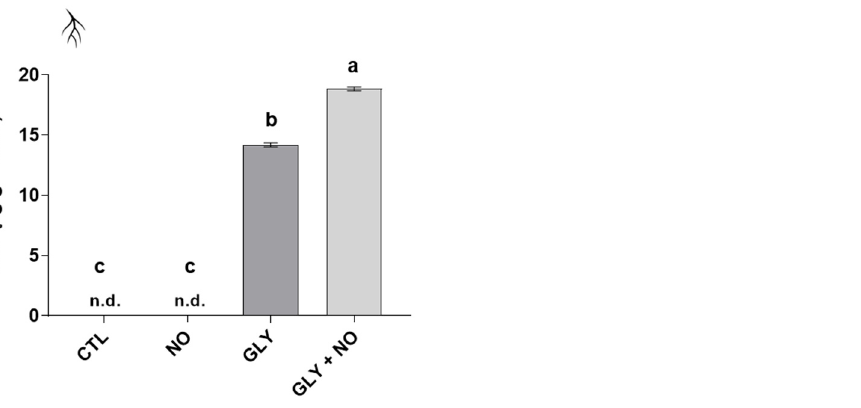
Figure 5. Bioaccumulation of GLY in roots of Solanum lycopersicum L. cv. Micro-Tom grown for 28 days in an artificial soil contaminated by GLY (10 mg kg − 1 ) and/or foliar sprayed with SNP (200 µM). CTL—control plants, grown in the absence of GLY and foliar sprayed with dH 2 O once a week (black); NO—plants grown in the absence of GLY and foliar sprayed with SNP once a week (dark grey); GLY—plants grown in the presence of GLY (grey); GLY + NO—plants grown in the presence of GLY and weekly sprayed with SNP (light grey). Results are presented as mean ± standard deviation (SD) and result from the evaluation of at least three experimental replicates ( n ≥ 3). Different letters above bars indicate significant differences between groups (CTL, NO, GLY and GLY + NO) at p ≤ 0.05, according to the one-way ANOVA followed by Tukey’s post hoc test; n.d.: non-detected, which means below the detection limit.